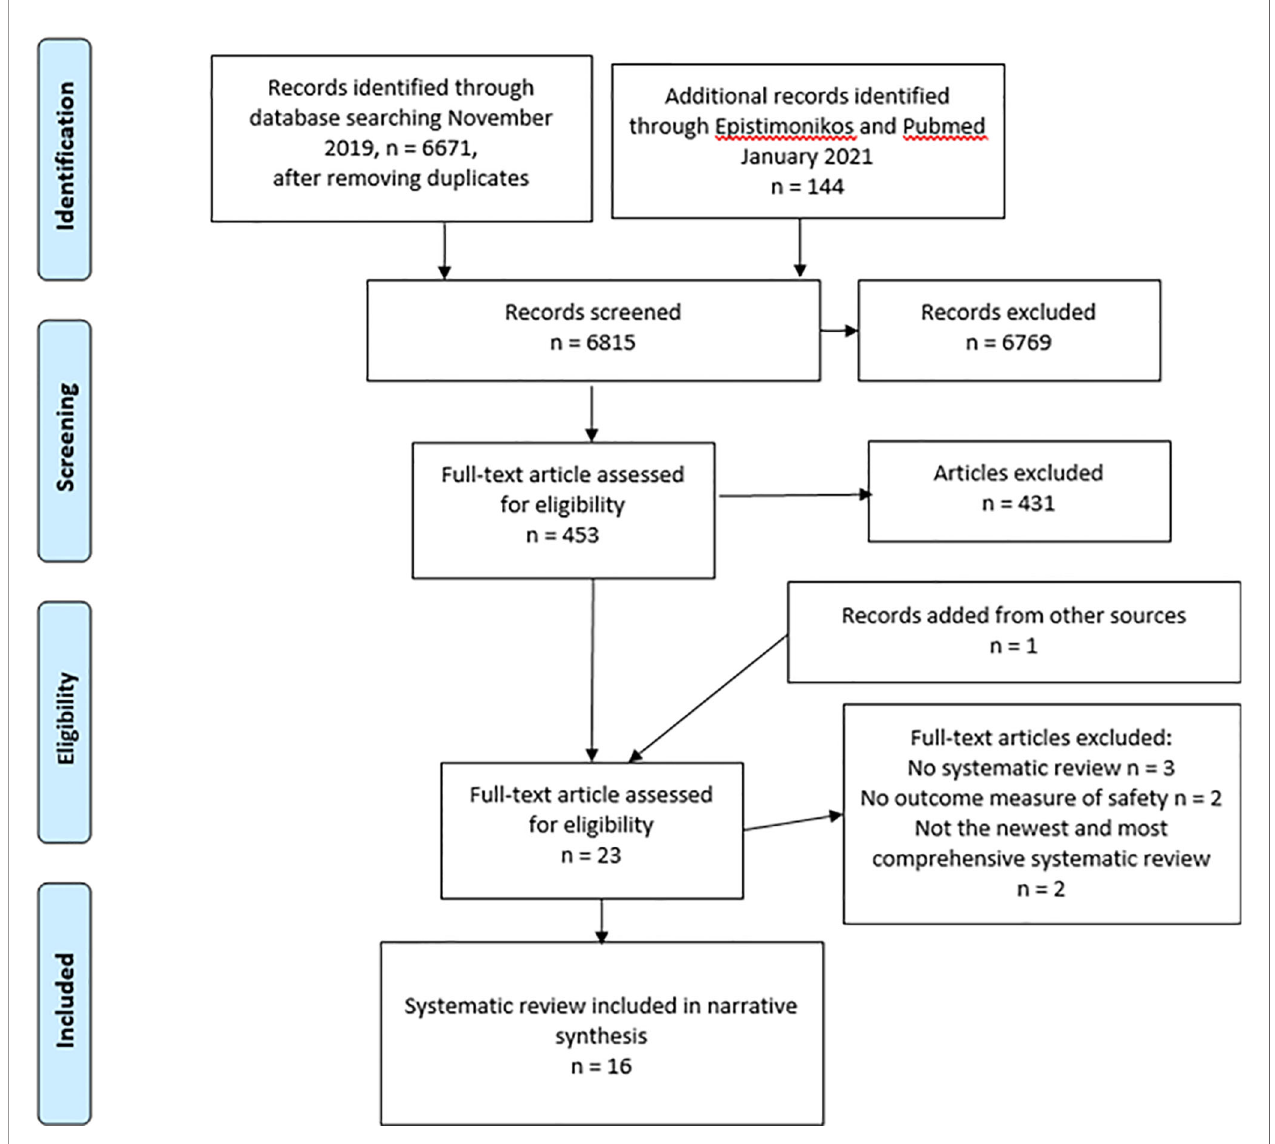
FIGURE 1 | Study selection, PRISMA fl ow